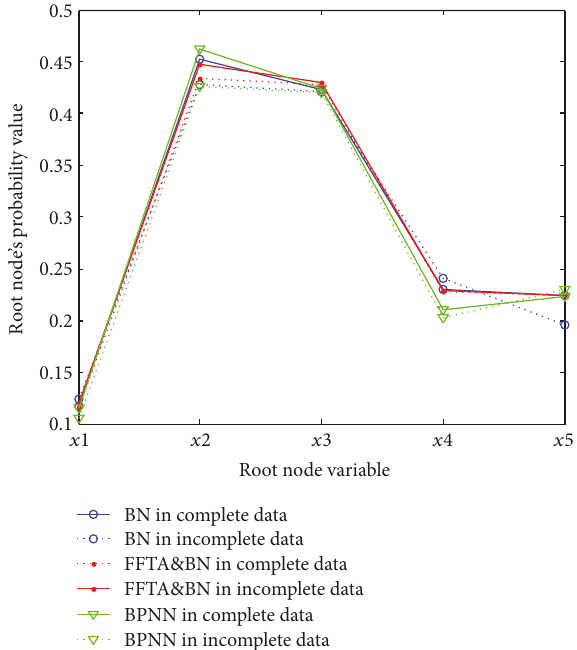
Figure 5: The fault probability of root nodes when the leaf nodes state is